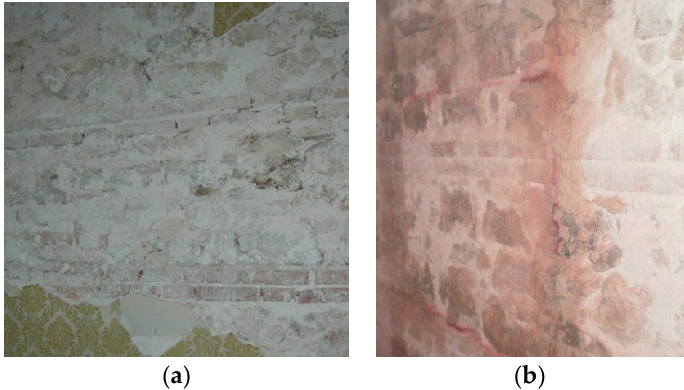
Figure 4. Stone masonry typologies: ( a ) Building No. 3; ( b ) Building No. 4.